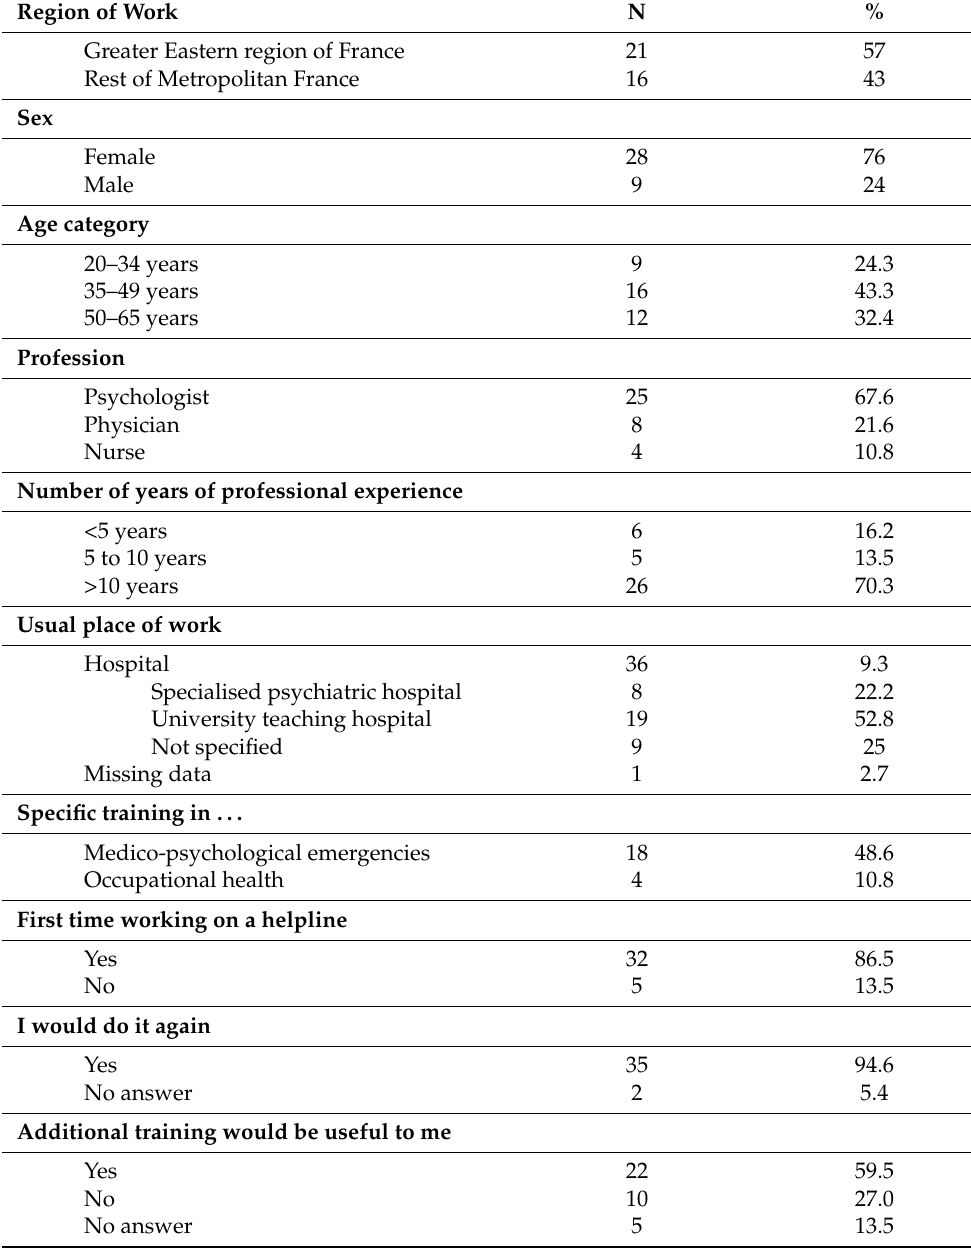
Table 2. Characteristics of the healthcare workers staffing the mental health support services (N = 37). Region of